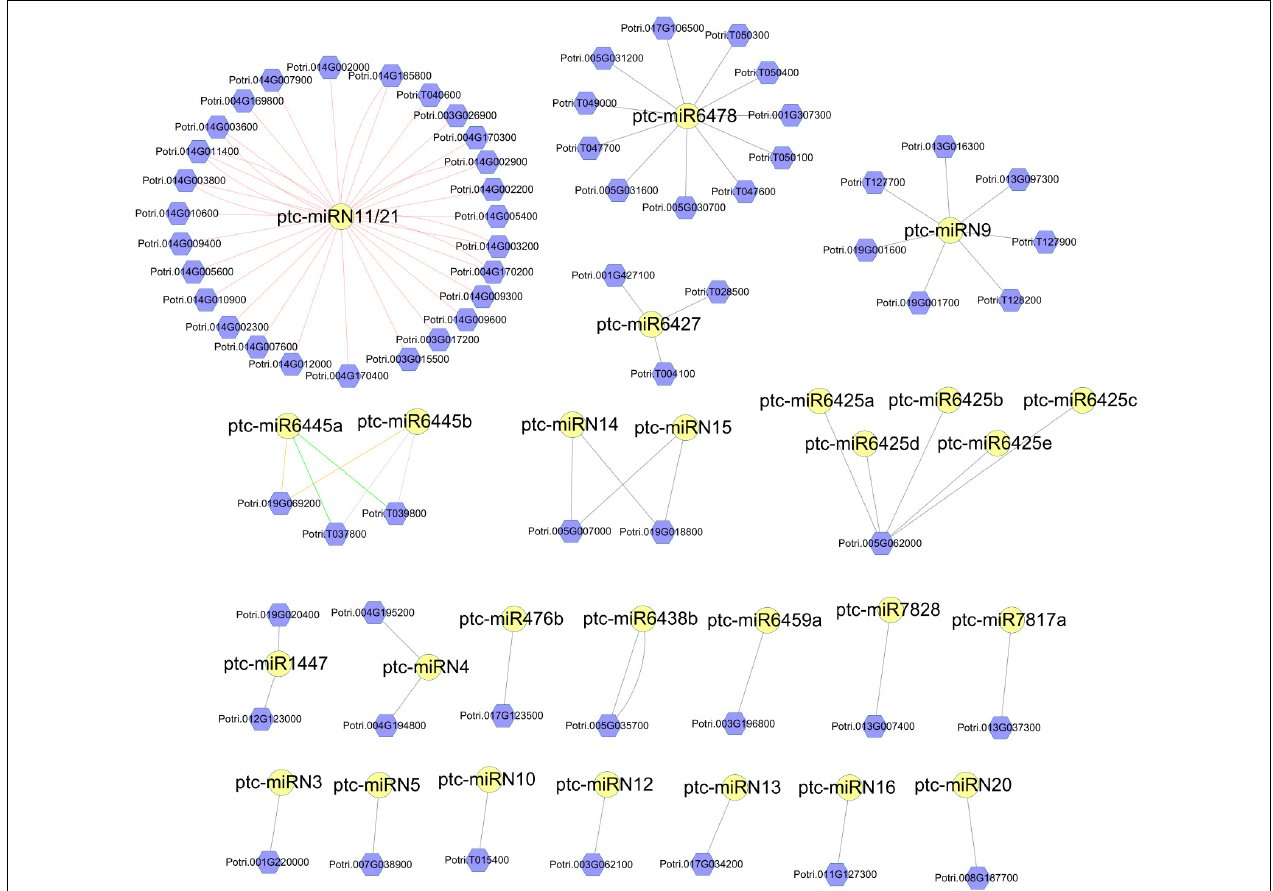
FIGURE 4 | Network of Populus -specific miRNA/disease resistance (DR) target gene pairs. The nodes with yellow circles are miRNAs. The nodes with violet hexagon are DR genes. The lines between miRNAs and DR genes represent the targeting relationship.